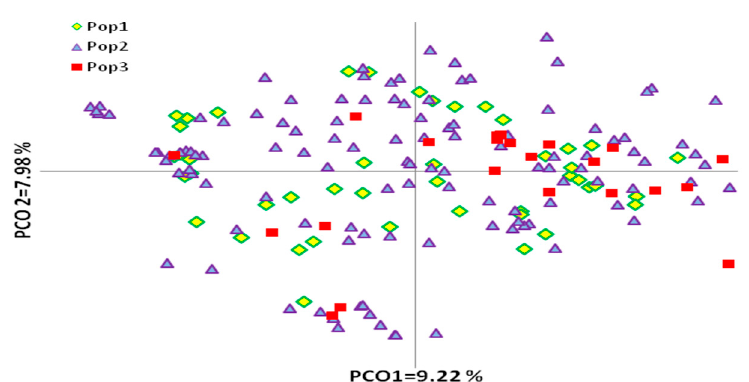
Figure 4. PCoA plot of 183 olive genotypes defined according to their fruit end-use. Pop 1—olive cultivars used for double purposes, Pop 2—cultivars used for oil production, Pop 3—cultivars used as table or canned olives production.